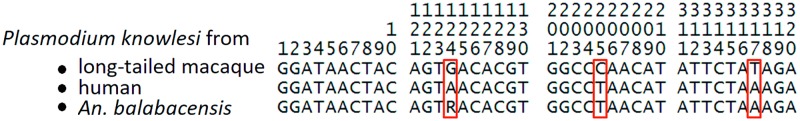
Consensus sequences of SSU rRNA of P. knowlesi isolated from long-tailed macaque, human and An. balabacensis in Sabah.The three variable nucleotides in the consensus sequences between the P. knowlesi isolates are shown within the red rectangles.